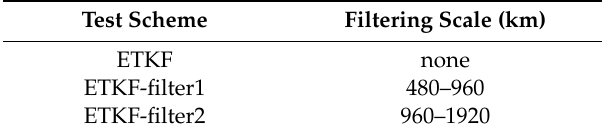
Table 1. Configuration of the filter settings for the three